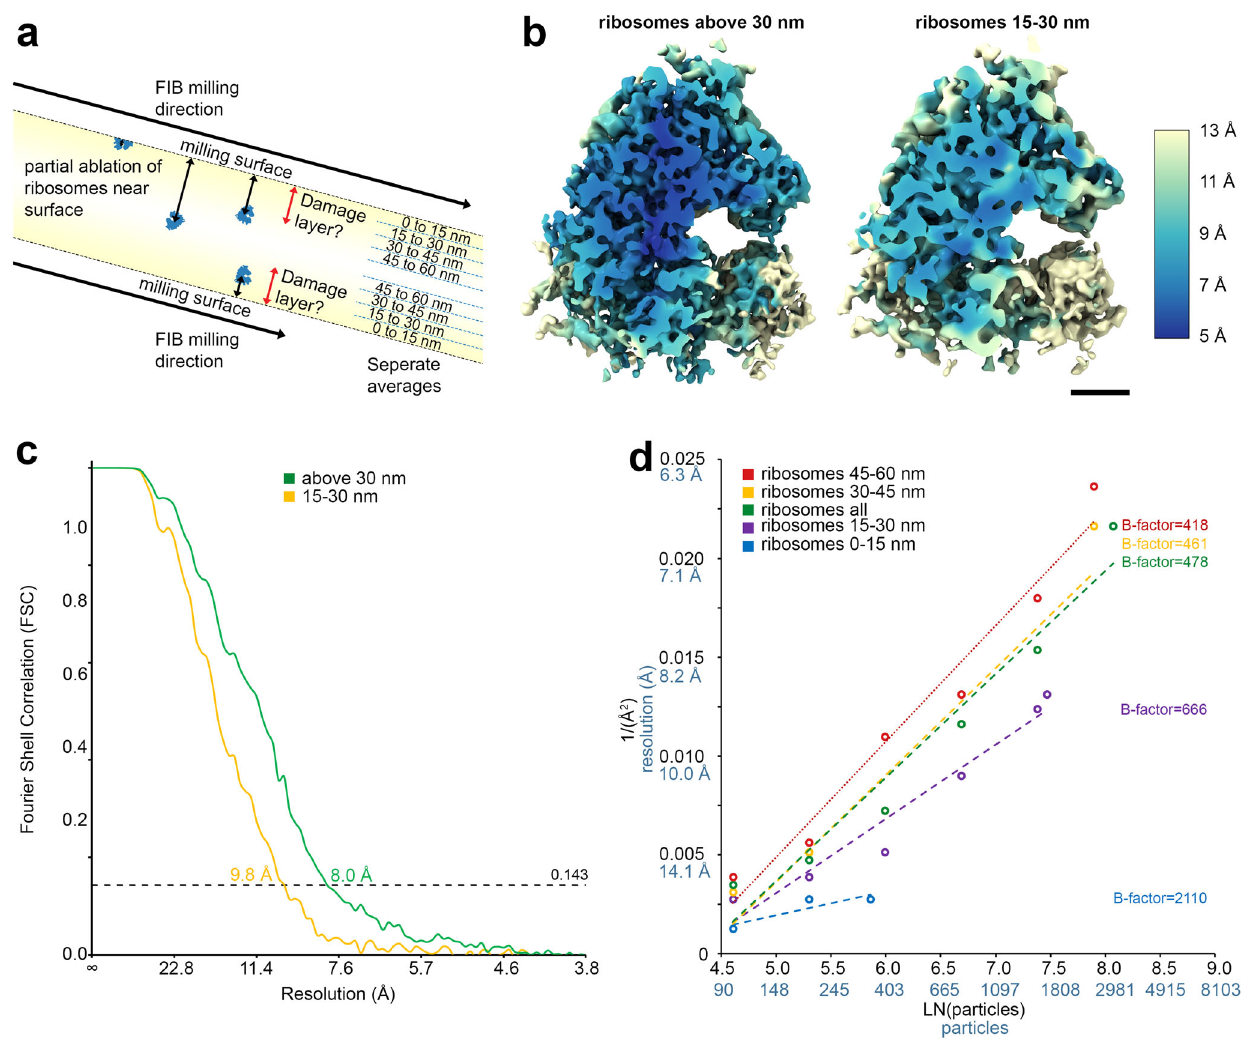
Fig. 4 | Effect of distance from the lamella edge on the ability to determine ribosome structures. a Schematic overview of ribosomes in a tomogram of a lamella and how the shortest distances of ribosomes to the top or bottom milling surfaces were obtained. These distances were used to create separate sub volume averageribosomestructuresin15nmincrementsawayfromthemillingsurfaces,to assesstheextentanddepthofthedamagelayercausedbyPFIBmilling. b Ribosome structures weredeterminedfrom acquired tomograms, where1748particlestaken from >30nm away from the PFIB milling surfaces (left) and between 15 and 30nm